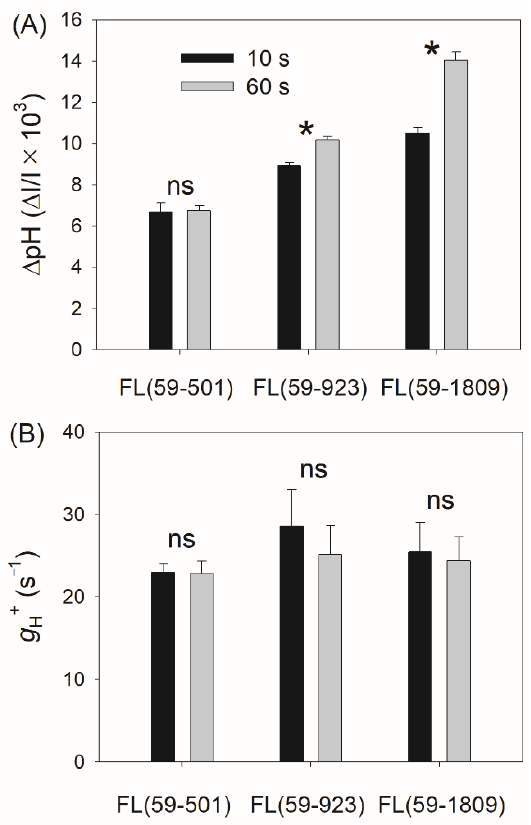
Figure 5. Changes in the proton gradient ( ∆ pH) across the thylakoid membranes ( A ) and chloroplast ATP synthase activity ( g H+ ) ( B ) under different fluctuating light conditions. ∆ pH and g H+ were measured after the transition from 59 to 501, 923 or 1809 µ mol photons m − 2 s − 1 for 10 s and 60 s. Data are shown as means ± SE ( n = 5). The asterisk (*) indicates a significant difference between 10 s and 60 s, “ns” represents no significant difference.